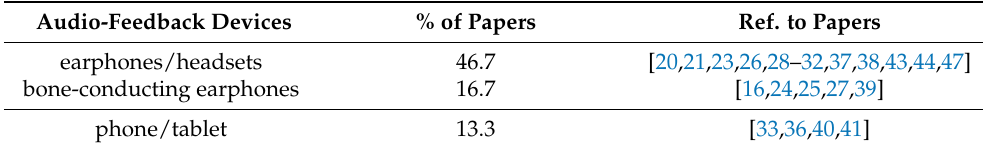
Table 6. Devices for audio